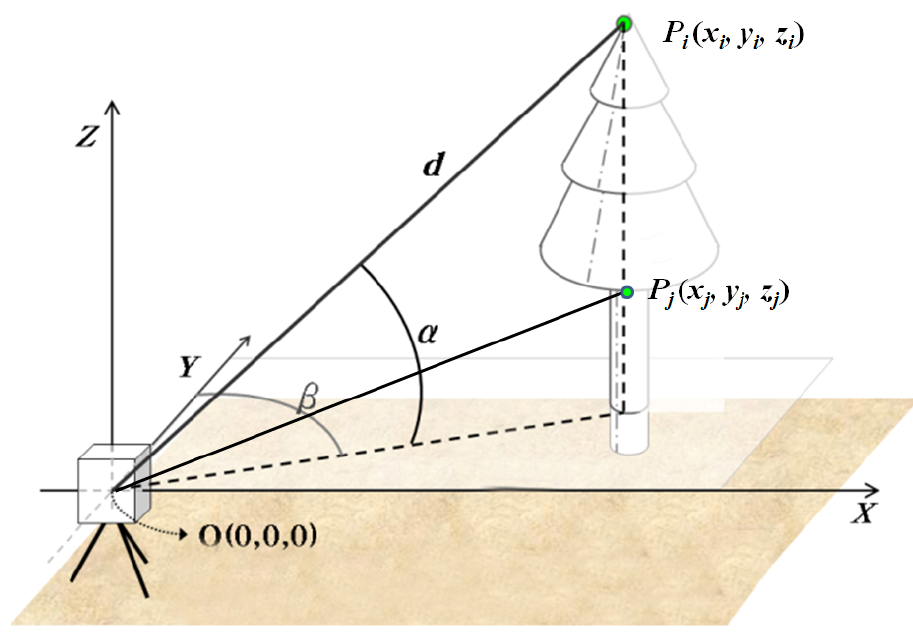
Figure 4. Estimation of tree height (TH) ( P distance ( d ) and angles ( α and β ) between TLS and individual